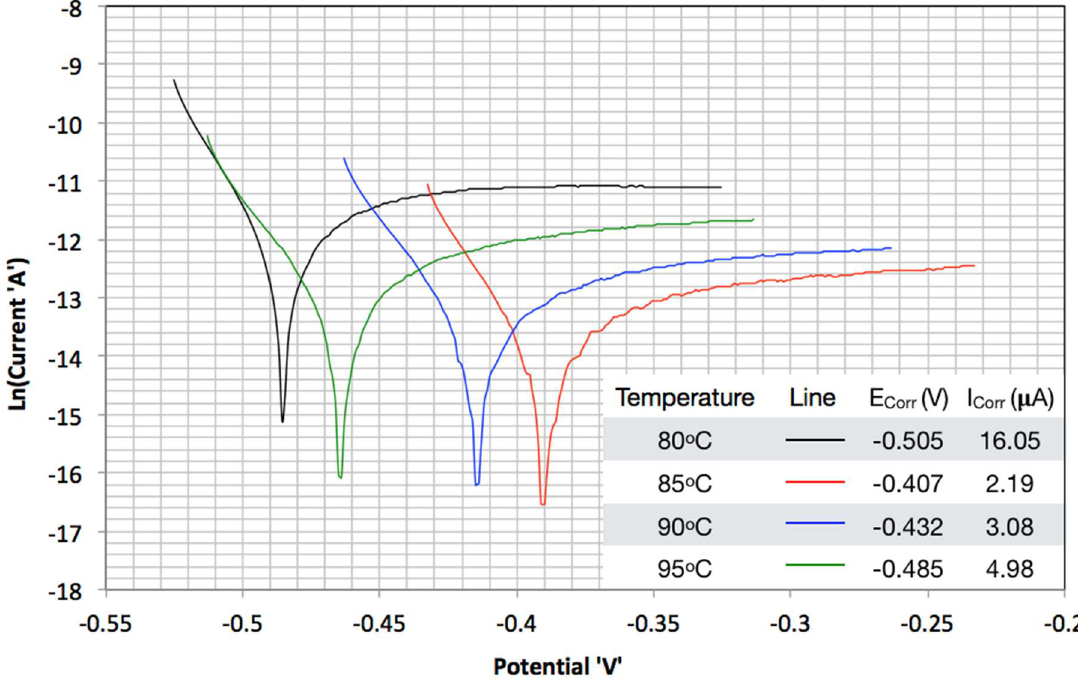
Figure 5. Tafel curves of [bmim][MS] and 10% MDEA with CO 2 at different temperatures. Scan rate = 1 mV/s. Fitted results for corrosion rates and potential are provided in the table.